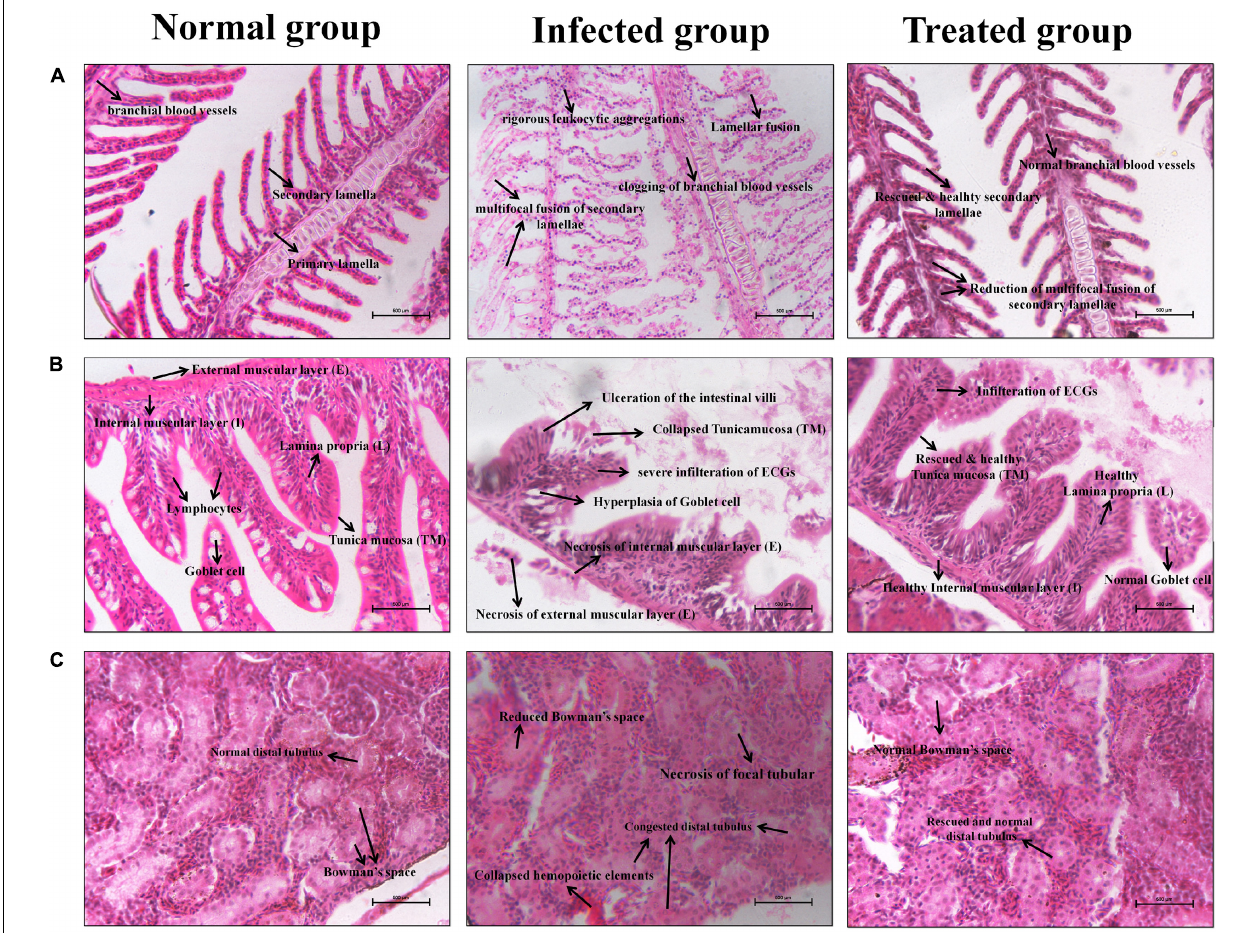
FIGURE 10 | Histopathology analysis of the Gills (A) , Intestine (B), and Kidney (C) sections of uninfected control, C. albicans infected control and morin treated